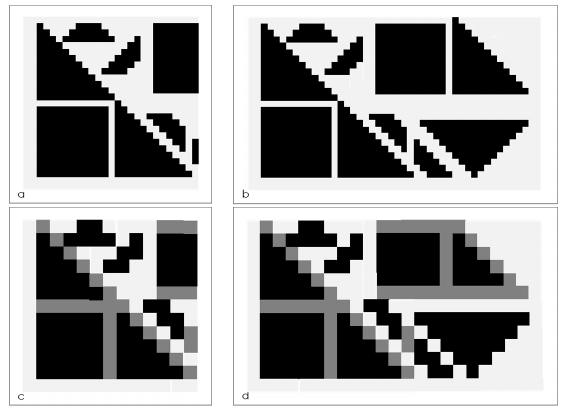
Figure 4. Effects of changes of resolution and scope over a 2D representation of polygons. Graphic